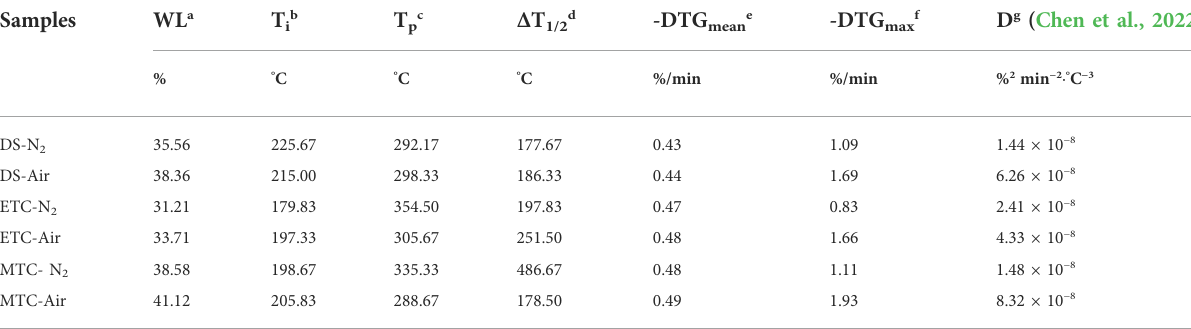
TABLE 2 Indexes of pyrolysis and combustion performance of different SS samples.